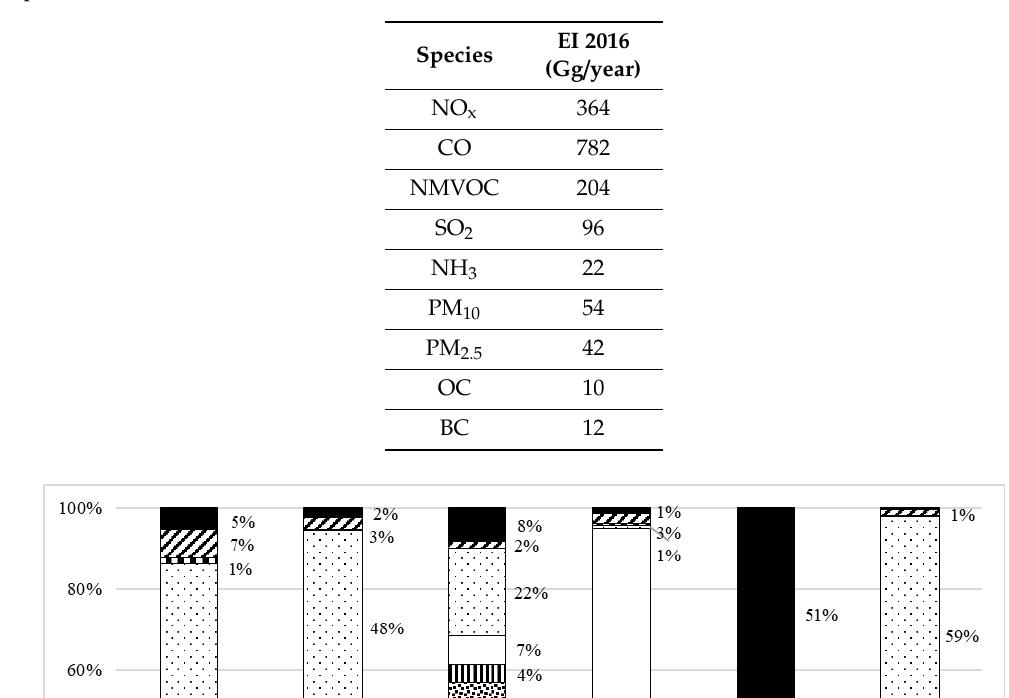
Table 3. Results of our emission inventory for BMR domain in 2016 (Bangkok city and surrounding provinces). Source: Ha Chi, 2018 (see text).